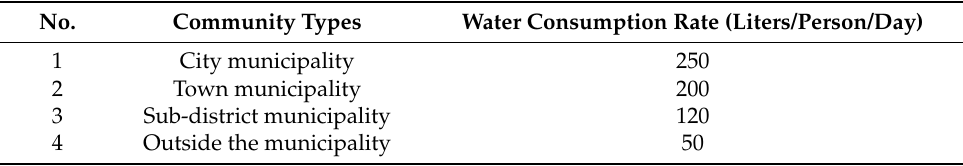
Table 4. Water consumption rates in different community